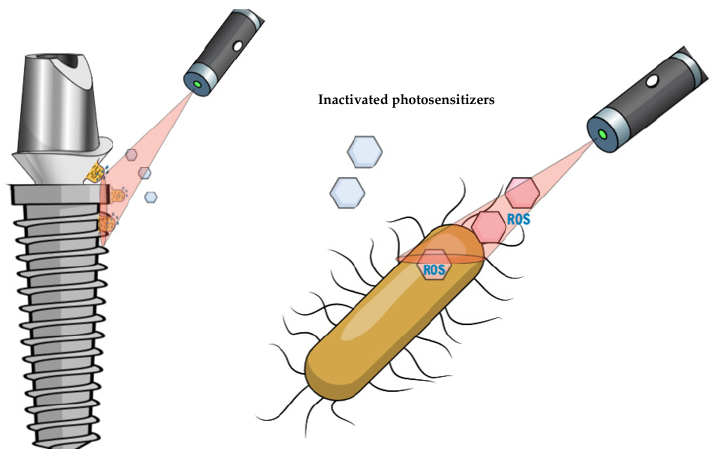
Figure 1. Antibacterial photodynamic therapy for implant decontamination. In peri-implantitis cases, bacterial biofilms develop on the prosthetic components and the exposed implant surfaces. toxic ROS release. ROS: reactive oxygen species, released after laser activation of photosensitizers.